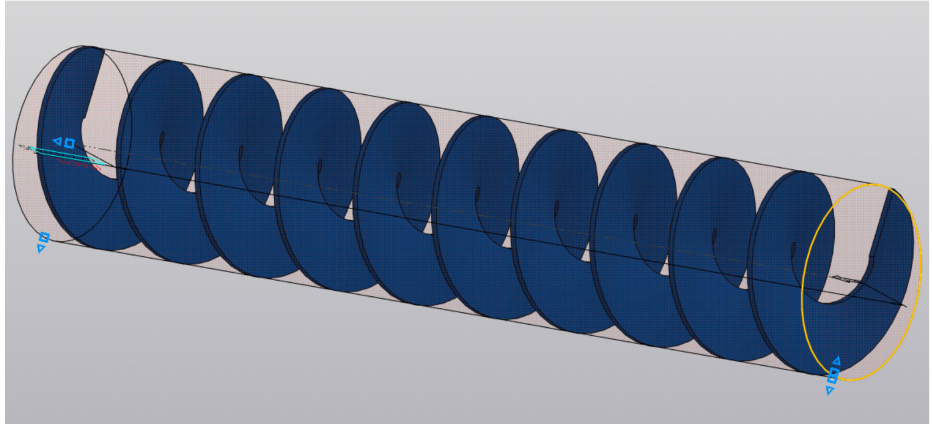
Figure 8. Illustration of the refractive index profile of a vortex fiber-optic periodic structure with obtained apodization and chirping, minimizing distortions of a two-frequency vortex